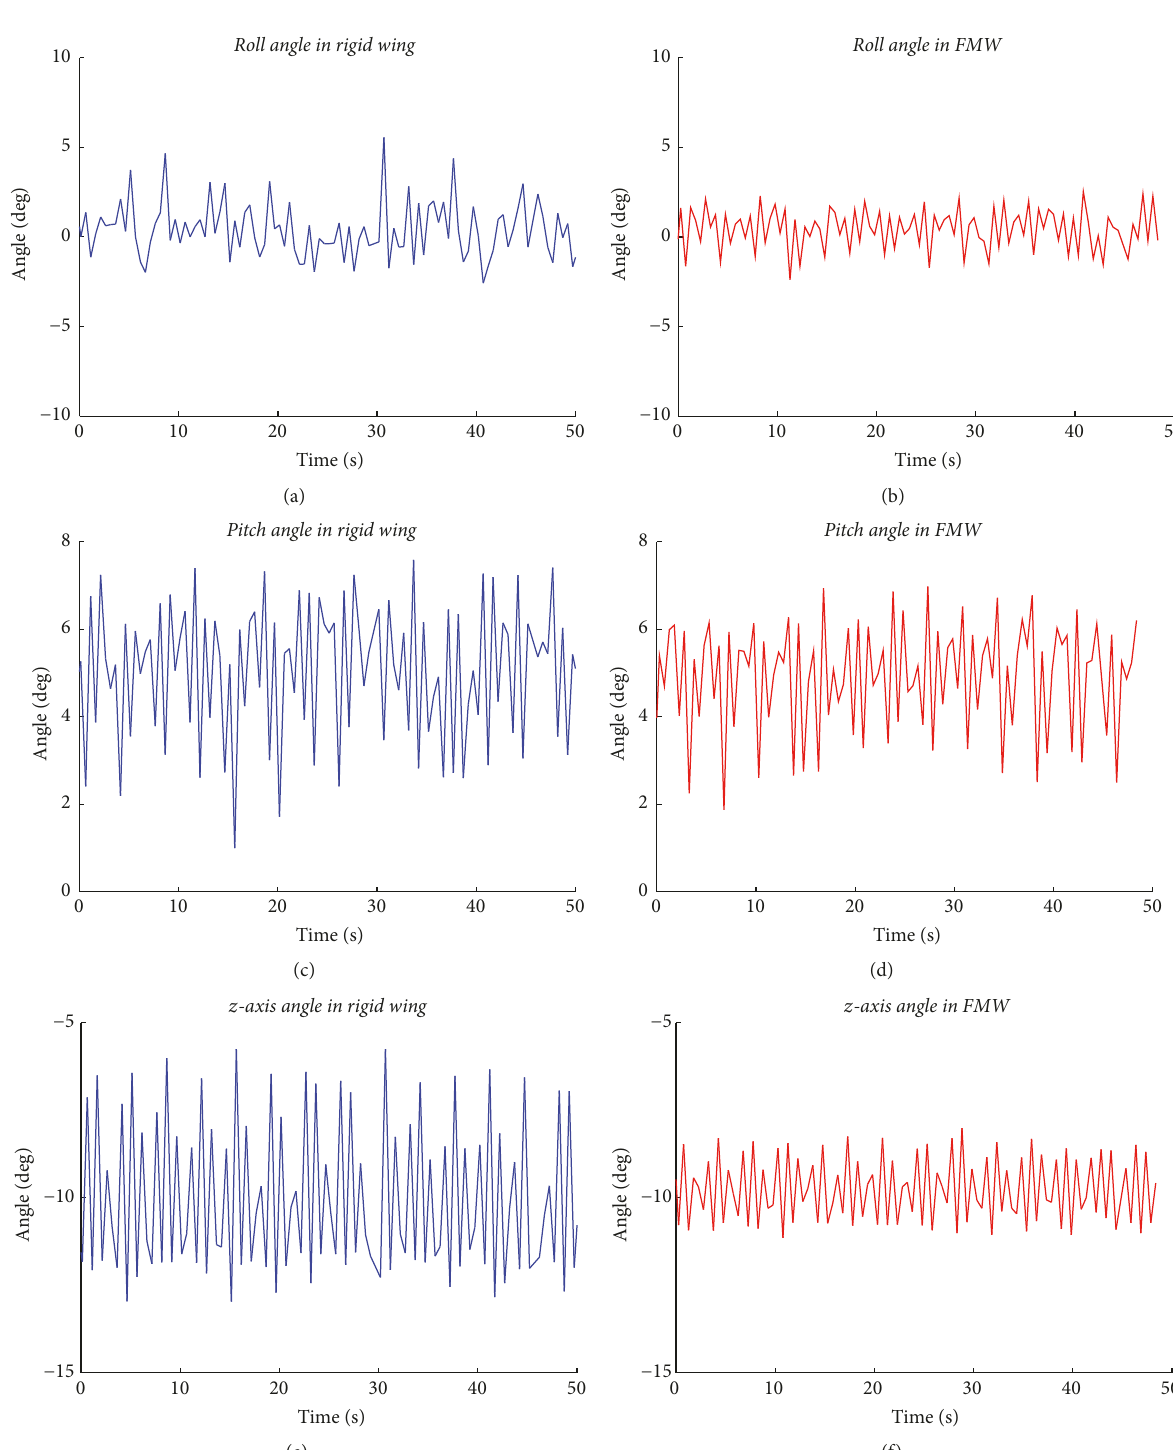
Figure 15: The roll and pitch angles and 𝑧 -axis acceleration of both the rigid wing and FMW model at 7 Hz longitudinal gusts. Rigid wing behavior is shown in (a), (c), and (e), while those from FMW are shown in (b), (d), and